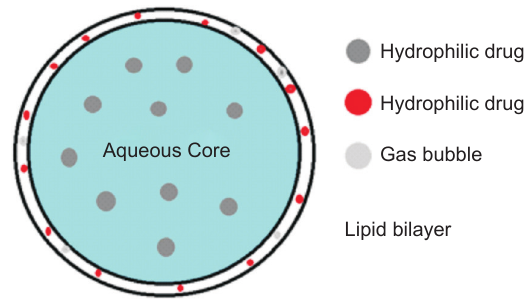
Figure 2 Illustration of a drug-loaded liposome with an aqueous core and gas bubbles in the lipid bilayer (can also be confined within the inner lipid layer in the same component as the aqueous core). Hydrophilic drugs can be loaded within the aqueous core and hydrophobic drugs can be loaded within the lipid